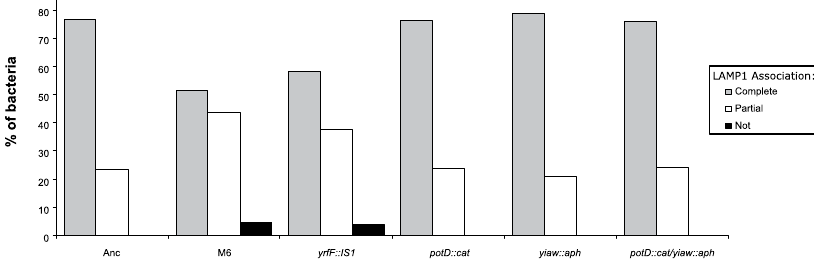
Figure 4. yrfF IS1 insertion is sufficient and necessary to cause phagosome maturation delay. Quantification of LAMP1 association with phagosomes containing Anc, M6, yrfF::IS1 , potD::cat , yiaw::aph or the double mutant potD::cat / yiaw::aph at 1 h